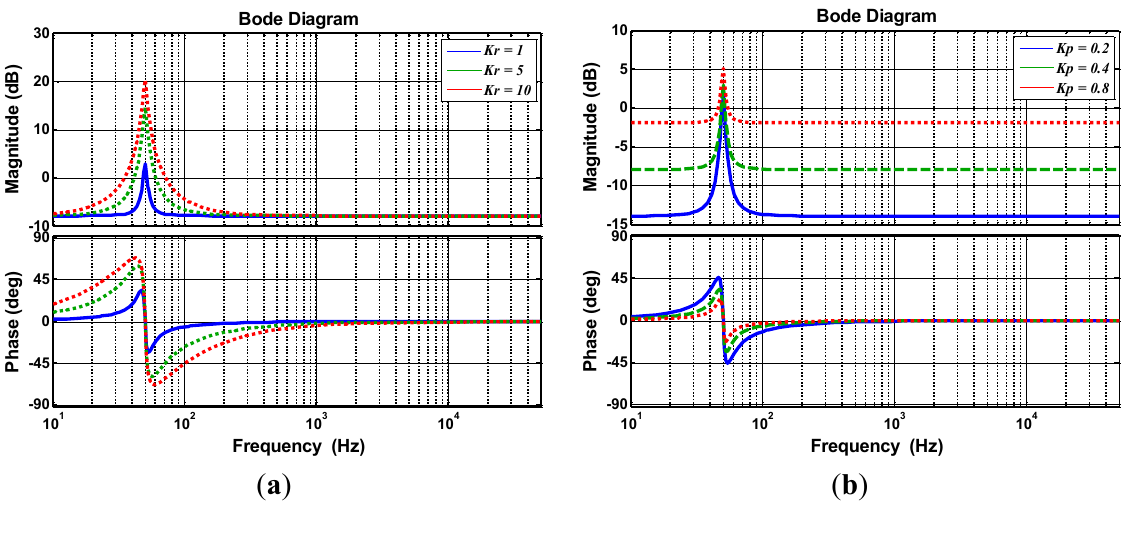
Figure 6. Improved PR controller Bode diagram: ( a ) K